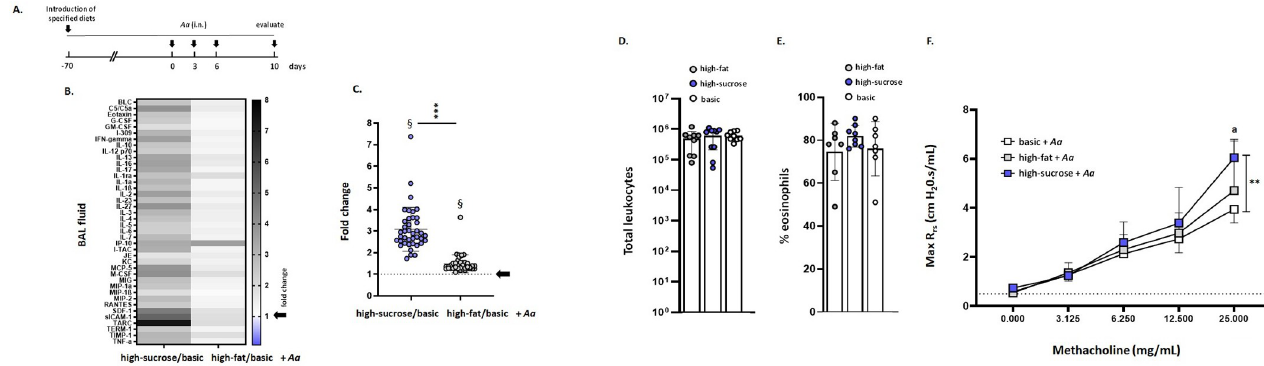
Fig 2. Cytokine and airway responses of wild-type mice maintained high-sucrose, high-fat, or basic diets after challenge with Alternaria alternata . (A) Protocol used for allergen challenge. After 70 days (10 weeks) on specified diets, mice were challenged intranasally with a filtrate of A . alternata ( Aa ; 50 μ g/ mouse in 50 μ L PBS) on days 0, 3, and 6 and evaluated on day 10 as previously described [27,28]. (B) Heatmap and ( C ) semiquantitative analysis of cytokine profiles detected in BAL fluid after repetitive challenge with Aa as in (A). The data shown are ratios of signals detected in BAL fluid from Aa -challenged mice maintained on high-sucrose or high-fat diets, each normalized to signals from BAL fluid from Aa -challenged mice maintained on the basic diet and presented fold-increase, n = 5 mice as described in the Methods. Arrows indicate no increase over signal detected in mice on basic diet (fold change = 1.0). Mean and SD for all cytokines are as shown in (C) at 3.1 ± 1.0 (high-sucrose/basic) and 1.5 ± 0.41 (high fat/basic); ��� p < 0.001 (high-sucrose/basic vs . high-fat/basic, Mann- Whitney U-test); § p < 0.001 vs . theoretical mean (= 1.0), one-sample t-tests. See S1 Fig for additional information. (D) Total leukocytes and (E) % eosinophils detected in BAL fluid of Aa -challenged mice maintained on high-fat, high-sucrose, or basic diets. (F) Total airway resistance (R rs ; cmH 2 O.s/mL) observed in response to increasing concentrations of methacholine (0–25 mg/mL) in mice maintained on basic, high-fat, or high-sucrose diets followed by Aa challenge as (A), n = 5 mice per group; a statistically significant increases in R rs detected in Aa -challenged mice over levels observed their respective baselines as shown in Fig 1F; �� p < 0.01 high-sucrose + Aa vs . basic + Aa , 2-way ANOVA with Tukey’s post hoc